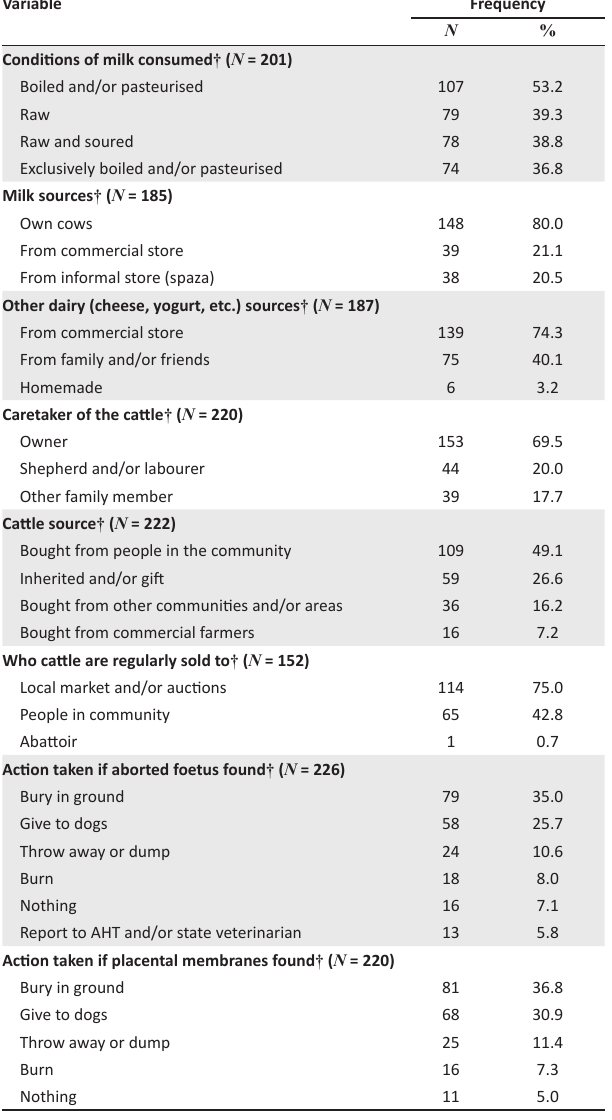
TABLE 4: Responses of participants regarding practices relating to dairy consumption and cattle husbandry, Whittlesea community, South Africa, 2017 (reflecting the outcome of some of the questions on